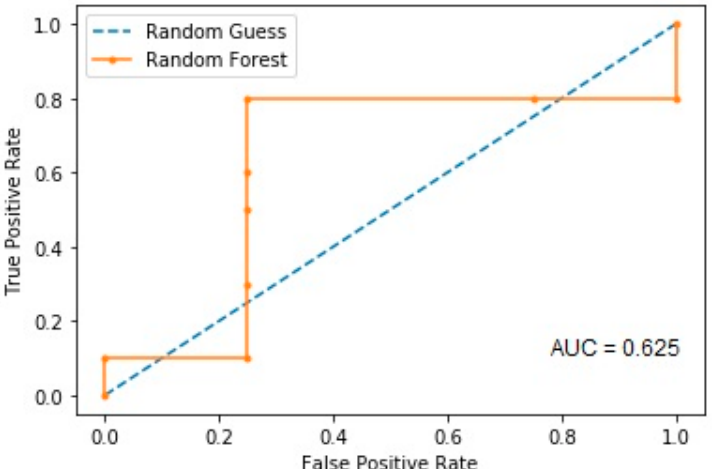
Figure 2. Area under the ROC curve for the prediction of cognitive decline.